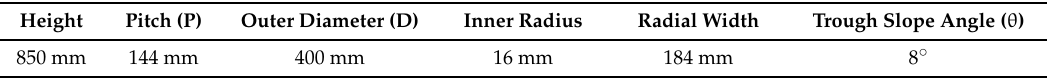
Table 3. Physical structure parameters of the spiral.